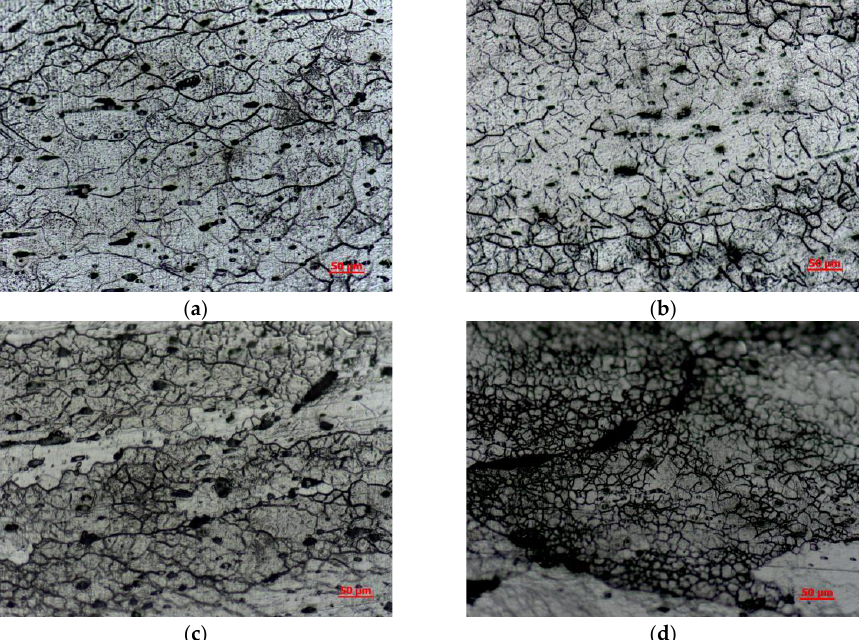
Figure 13. Deformation microstructure of Fe-Cr-Al-La stainless steel compressed to a strain of 0.916 at a strain rate of 0.1 s −1 and at ( a ) 1150 °C, ( b ) 1100 °C , ( c ) 1050 °C, and ( d ) 1000 °C.